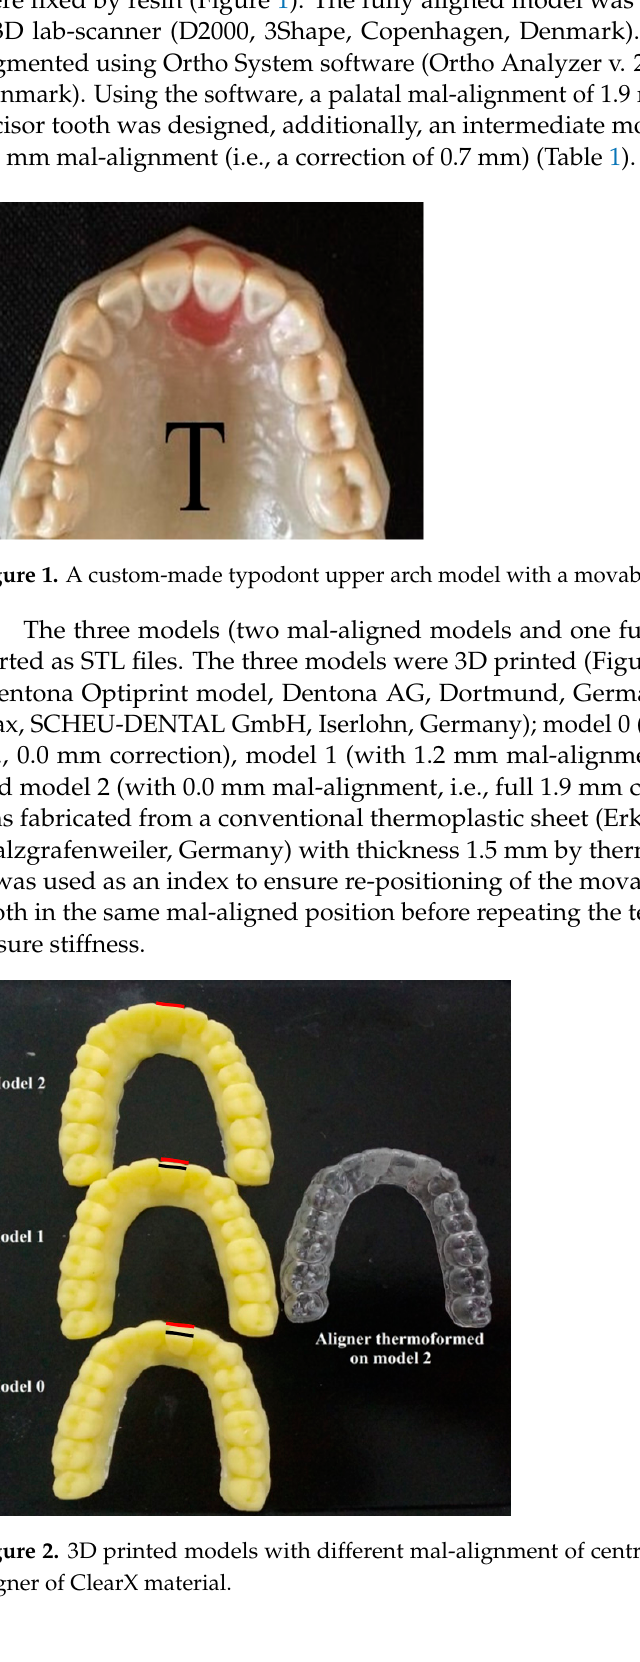
Figure 3. Thermopressed aligner on model 2 and reformed aligner on model 1. 2.2. Testing of Shape Memory Correction on the Typodont Model The wax around the upper left central incisor tooth in model T was softened. The guiding splint was used for positioning of the tooth in model T to be equally positioned as model 0. The model T was then placed in a 5 °C water bath for 10 min, to ensure that the wax is no longer soft and can withstand aligner placement without getting distorted [8]. Model T was then scanned (scan 1). The reformed aligner was then placed on model T, and together, they were placed in a hot water bath of 50 °C for 10 min. The model was placed on its base in a hot water basin and the water volume was adjusted to be at the level of the wax just below the aligner margin, to avoid, as much as possible, activation of the shape memory recovery of the aligner by the elevated temperature, meanwhile the wax was softened by hot water to allow the imbedded tooth to move. At the end, the